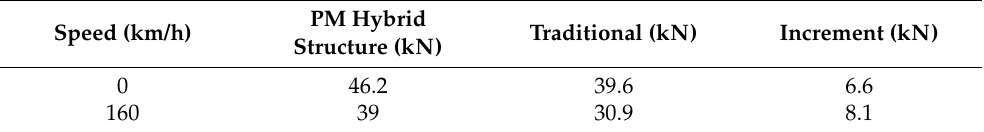
Table 5. Levitation Force of PM hybrid structure.